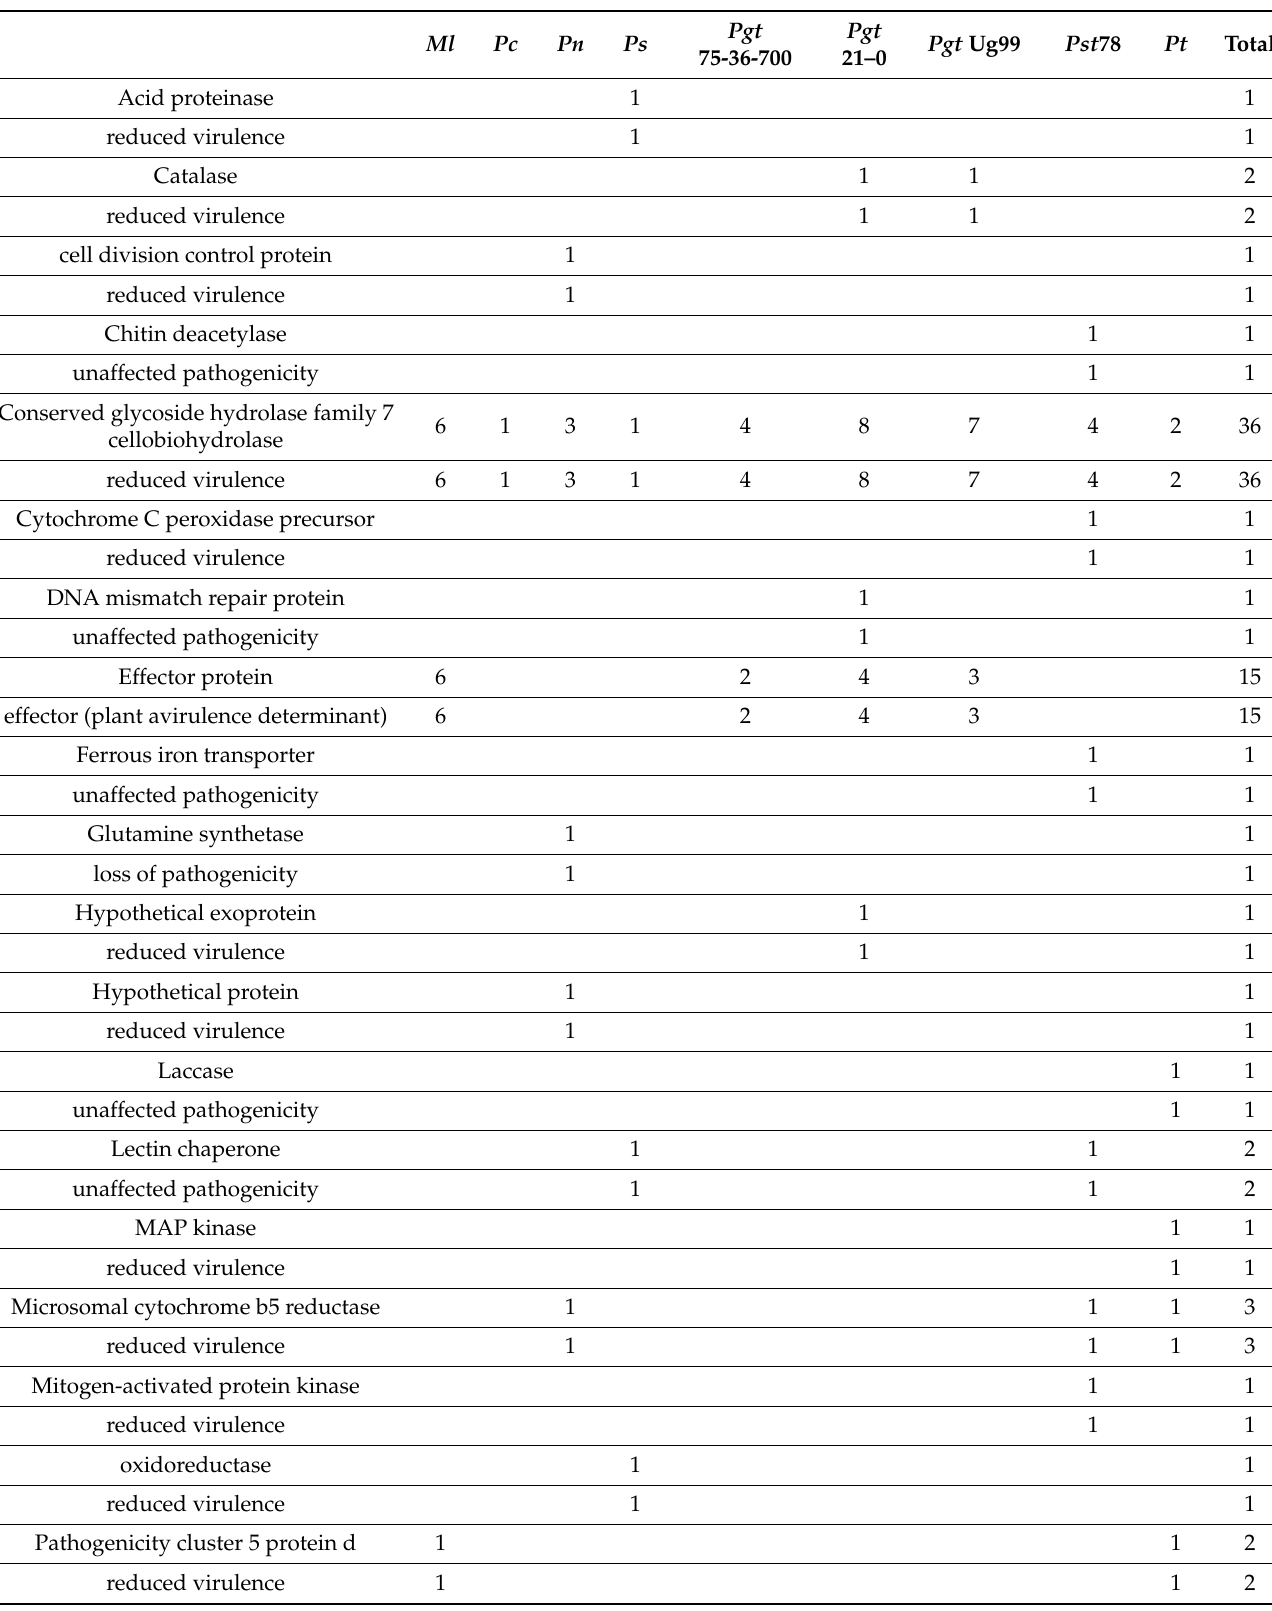
Table 4. Comparison of validated pathogenicity genes among Puccinia